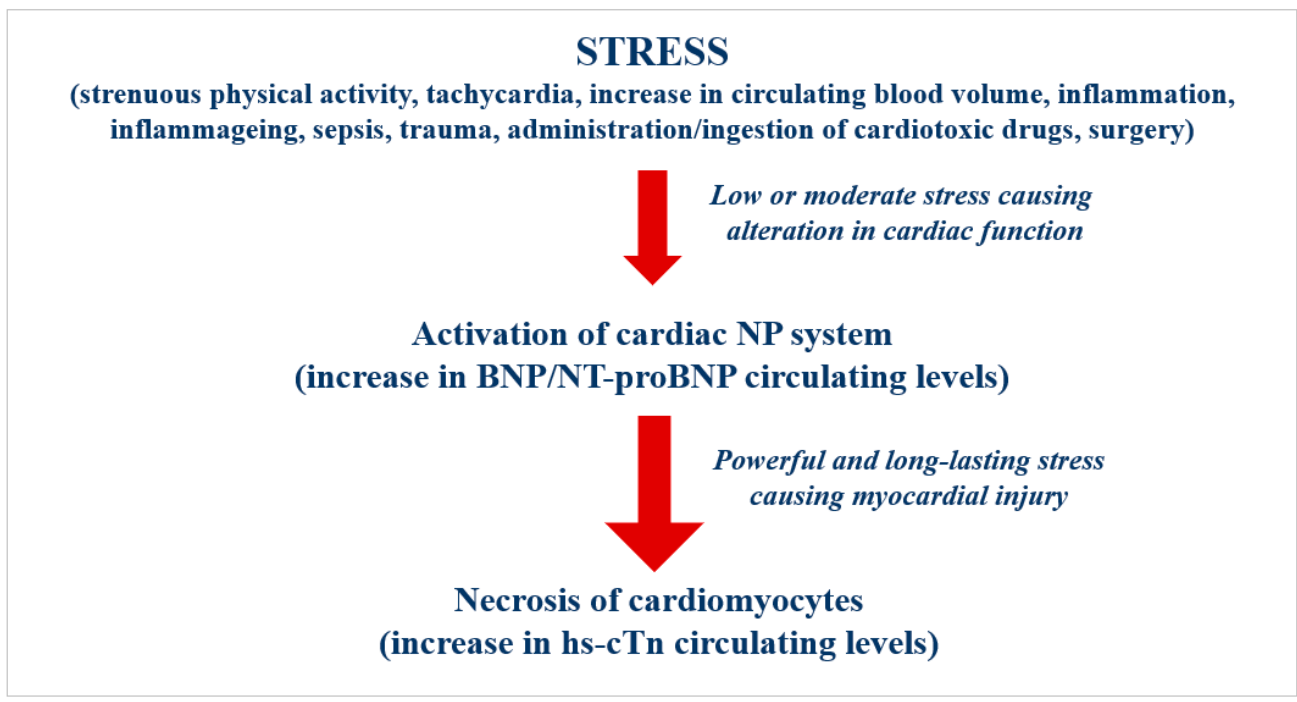
Figure 1. Relationship between stress and activation of cardiac peptide system and myocardial in- jury.